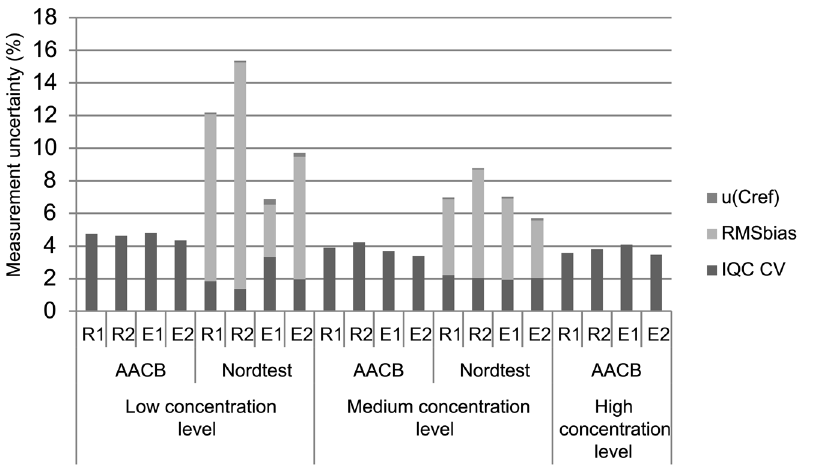
Figure 1: Measurement uncertainty of PLT of four autoanalyzers with two different guideline, with contribution rates of RMS bias , u ( c ref ) and imprecision of IQC. AACB, Australasian Association of Clinical Biochemists Uncertainty of Measurement Working Group Measurement Uncertainty Guideline; Nordtest, Handbook for Calculation of Measurement Uncertainty in Environmental Laboratories Guideline; u ( C ref ), uncertainty of external quality assurance sample; RMS bias , root mean square bias; IQC CV, imprecision of internal quality control; R1 and R2, two Beckman Coulter LH-780 autoanalyzers run in routine laboratory; E1 and E2, two Beckman Coulter DXH-800 autoanalyzers run in emergency